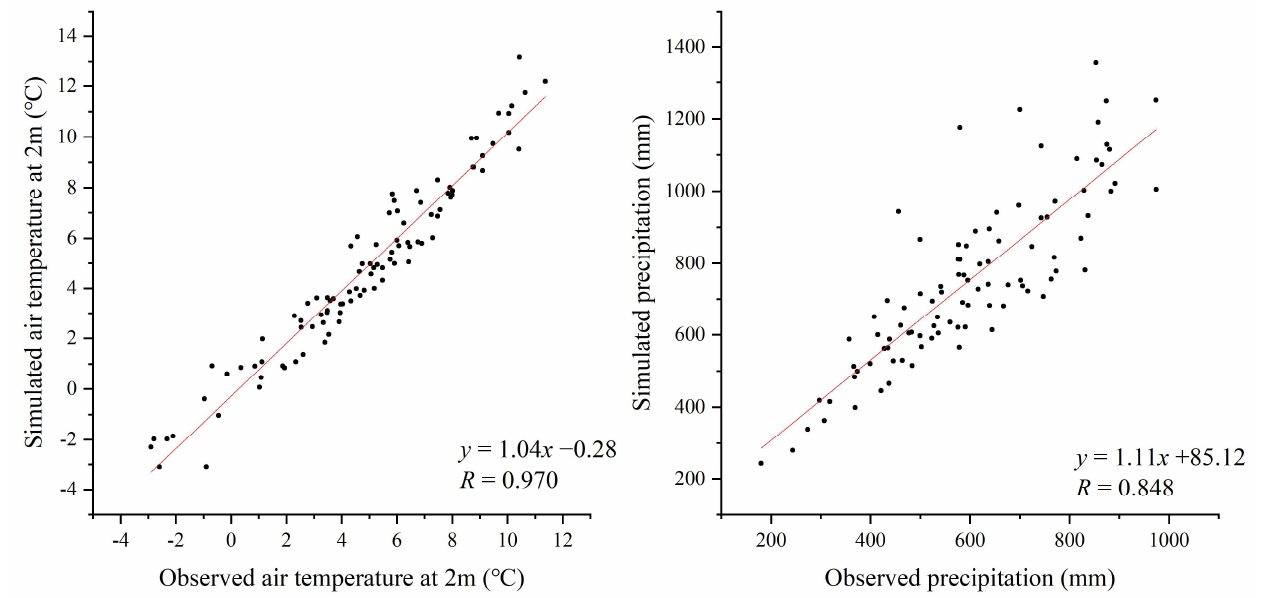
Figure 8. Simulated and observed air temperature at 2 m, and precipitation.